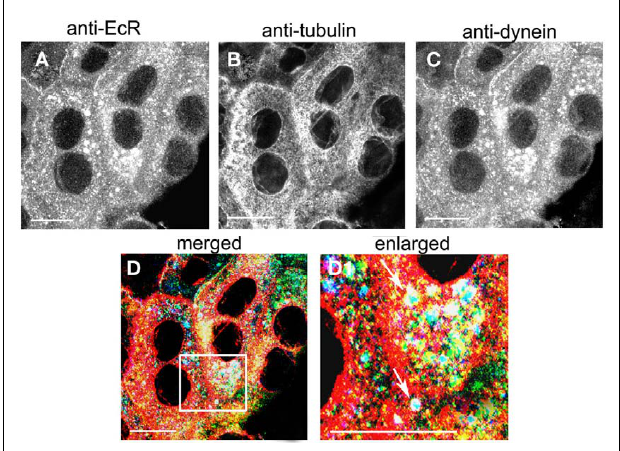
FIGURE 9 |Triple labeling of SG cells with anti-EcR [(A), green], anti-tubulin [(B), red] and anti-dynein [(C), blue]. Co-localization is shown in (D,D1) as white. Area enclosed in the white lined boxes in (D) is shown enlarged in (D1) to show details of co-localization. Note co-localization of EcR, tubulin, and dynein fluorescence in (D1) as white dots (arrows). Scale bars = 10 μ